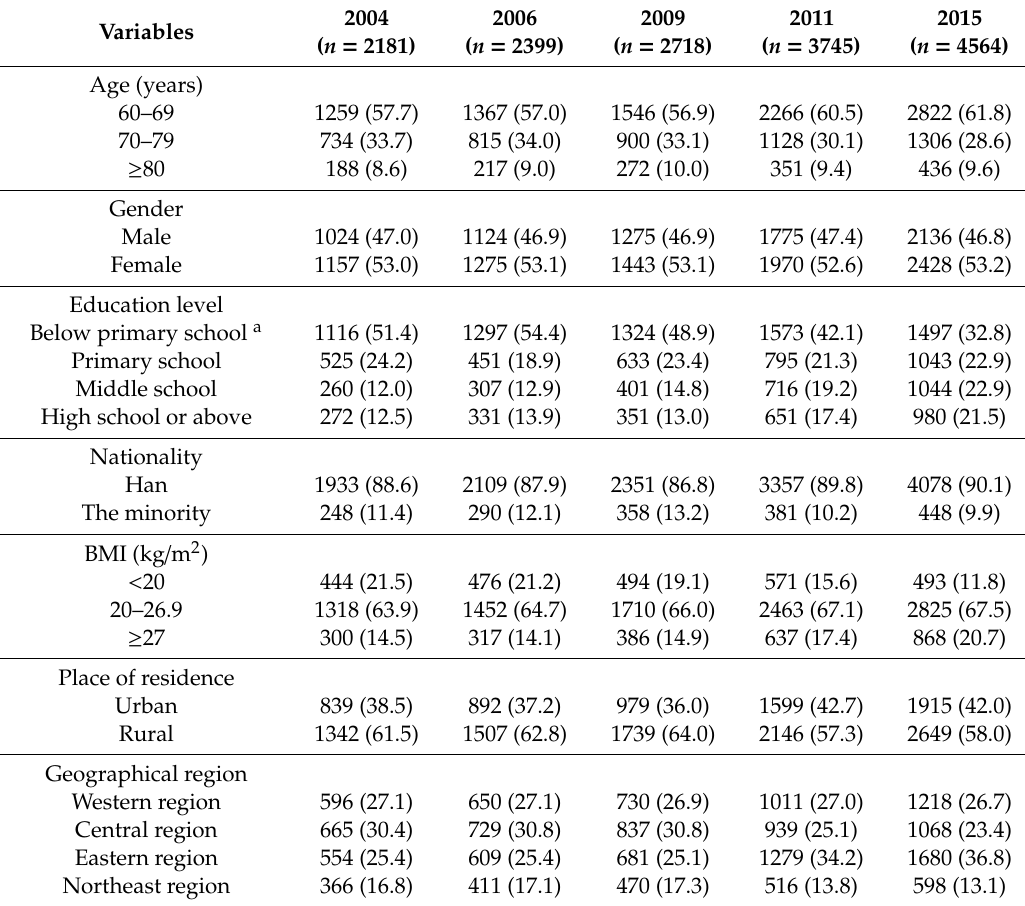
Table 1. Participants’ demographic